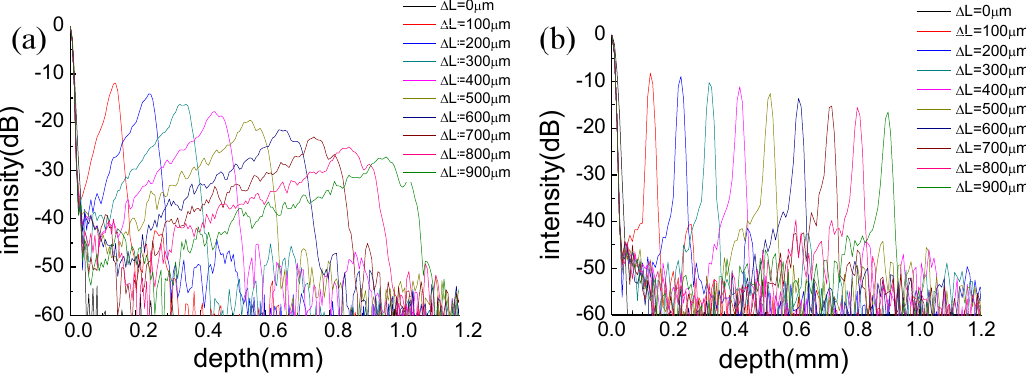
Figure 6. Point spread functions (PSFs) at various path length differences with ( a ) sinusoidal drive function; and ( b ) triangular drive function.